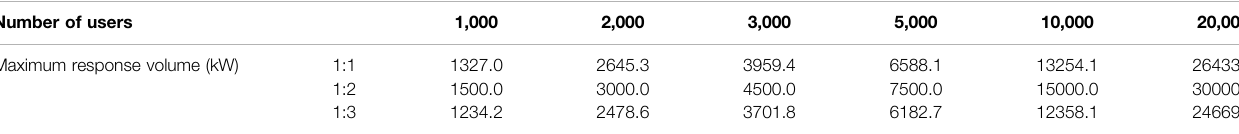
TABLE 1 | Maximum response volume of different numbers of users with different type ratios. Number of